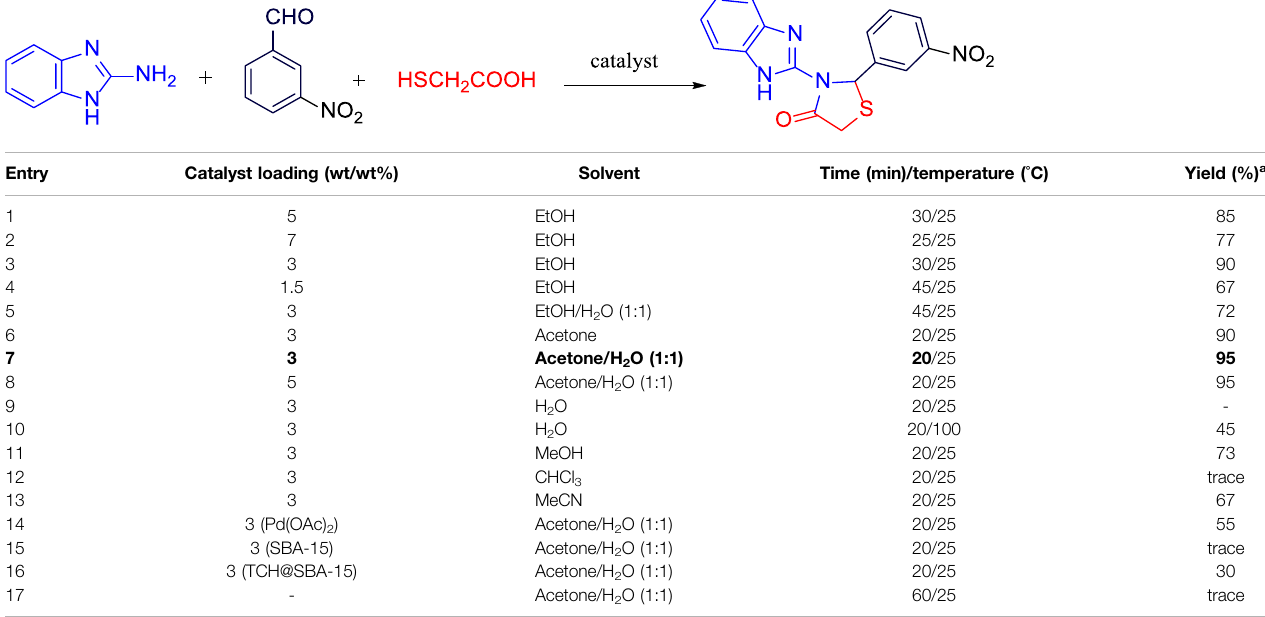
Bold values are for the optimal reaction conditions. a Isolated yield.